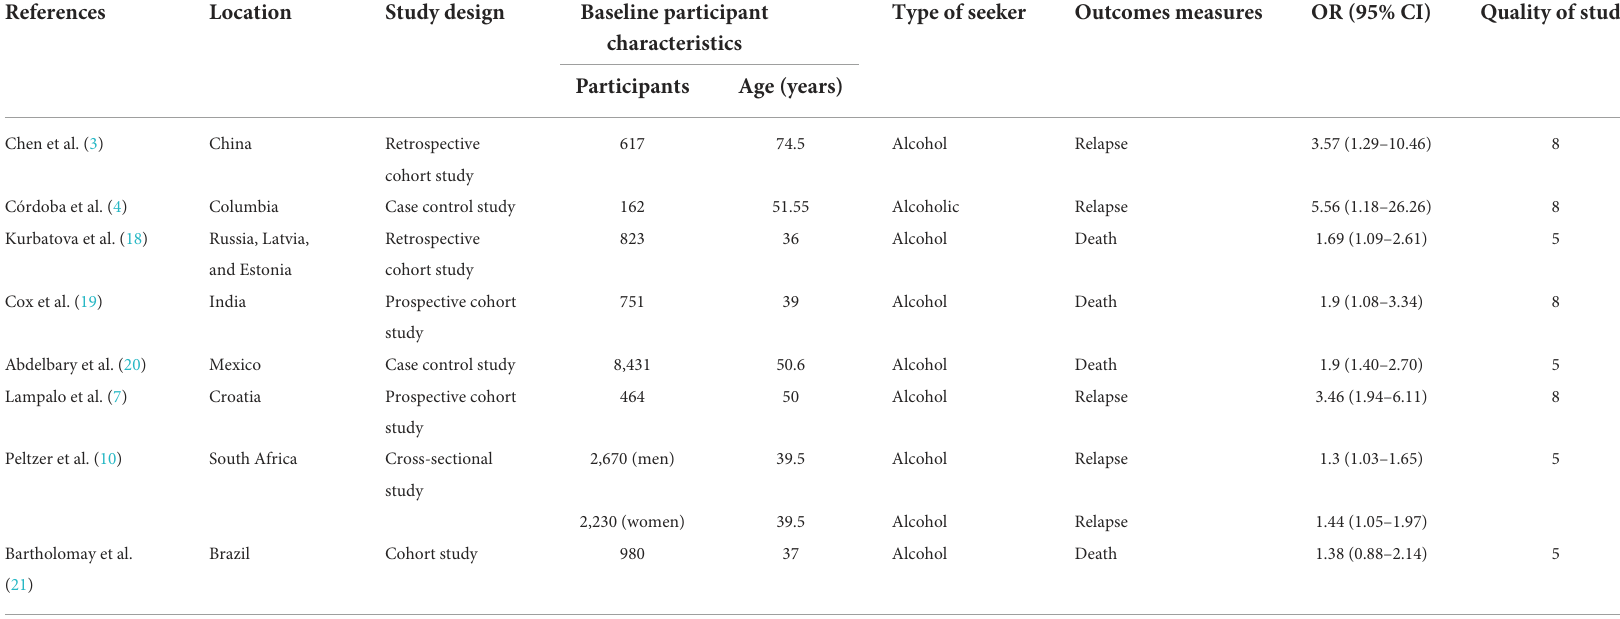
TABLE 1 General characteristics of eight studied